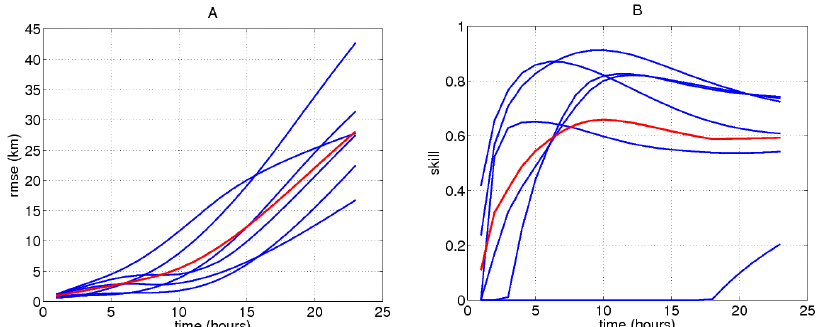
Figure 4. ( A ) The blue lines are the RMSE of separation distances computed from the comparison between TSCRM and both drifters trajectories released on October 29, 2017. The red line is the averaged RMSE. ( B ) The blue lines are the skill score; the red line is the averaged trend.